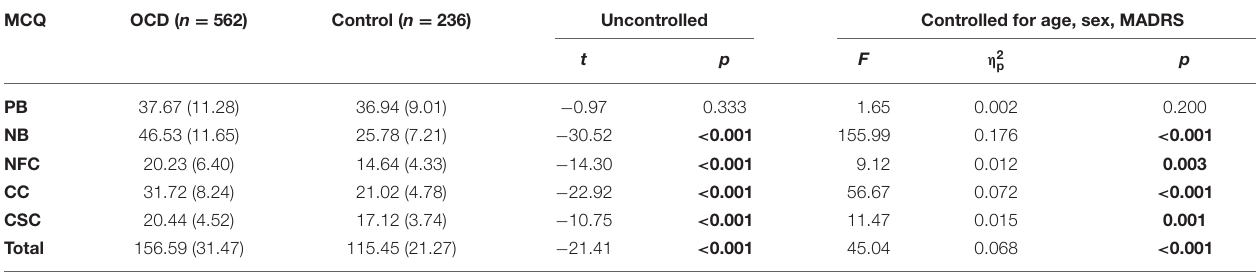
TABLE 2 | Comparison of MCQ scores between patients and controls.